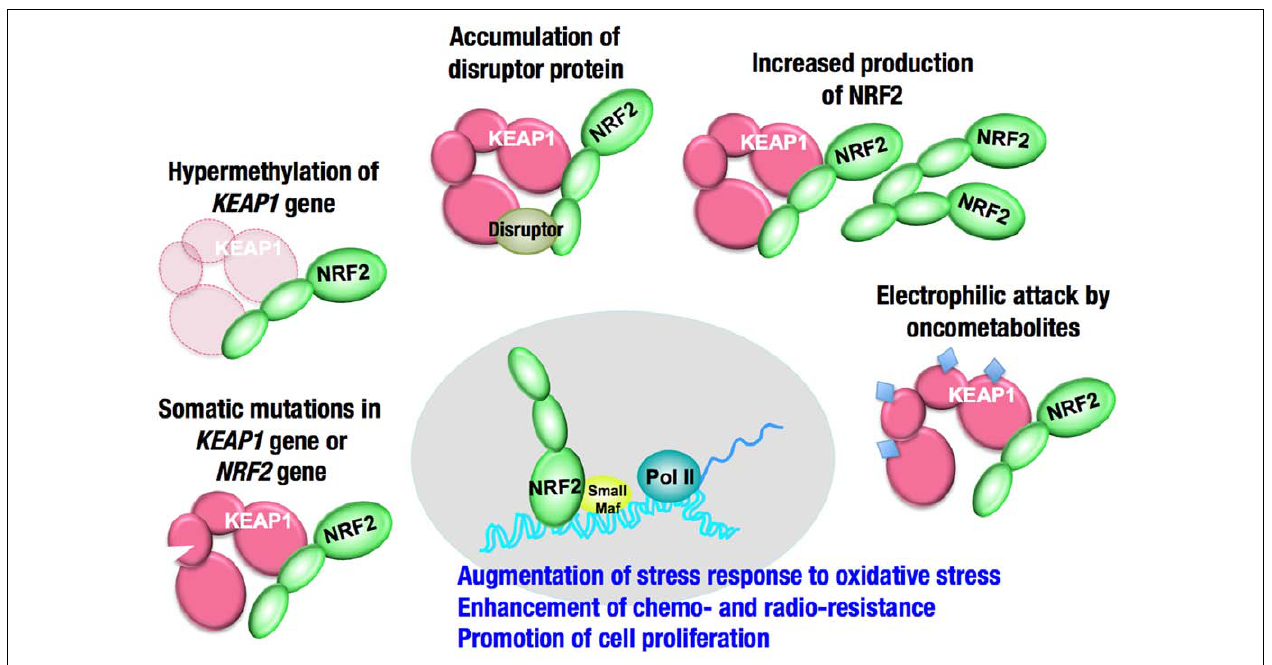
FIGURE 5 | Increased activity of NRF2 in cancer cells. The degradation of NRF2 is inhibited in some cases, and the production of NRF2 is increased in other cases.